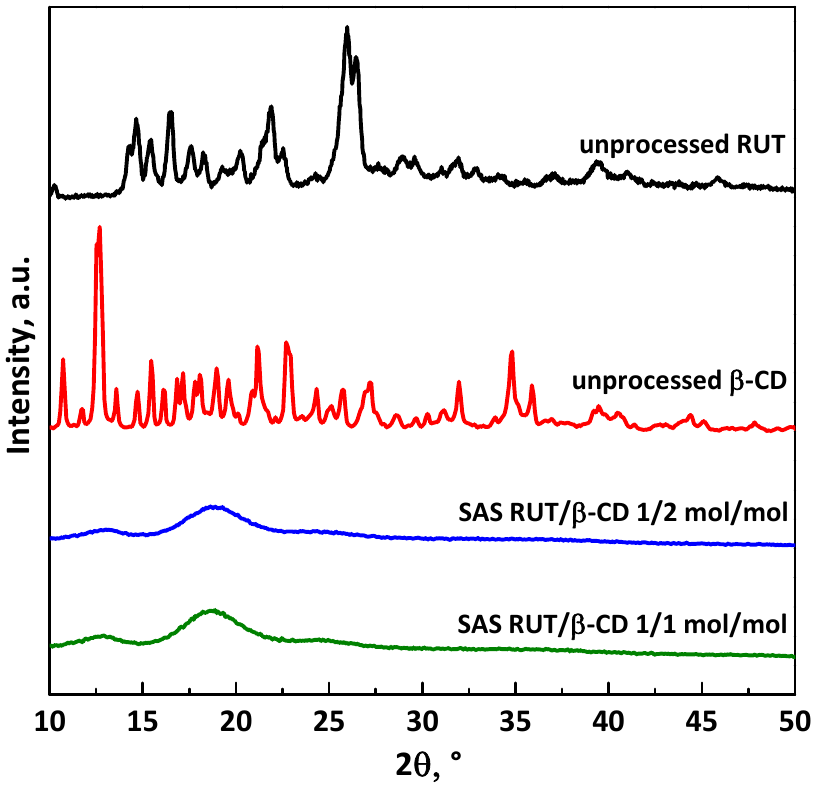
Figure 9. XRD patterns of unprocessed RUT and β -CD, and SAS-processed RUT– β -CD powders at different molar ratios.